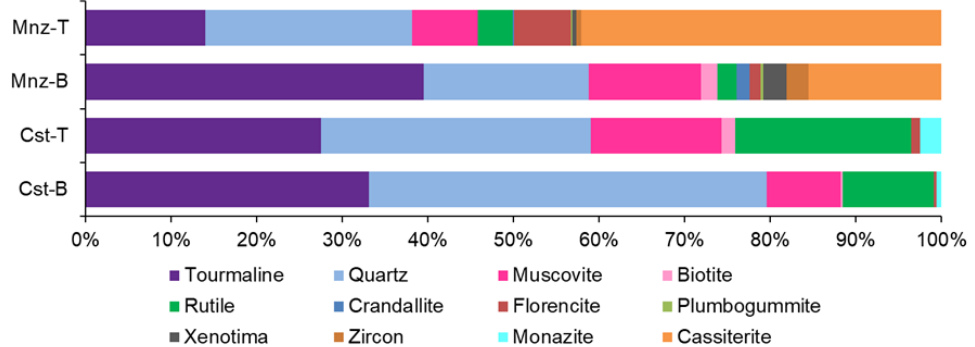
Figure 9. Mineral association of the non-liberated ore: Cst-B cassiterite in binary particles, Cst-T cassiterite in ternary particles, Mnz-B monazite in binary particles and Mnz-T monazite in ternary particles.